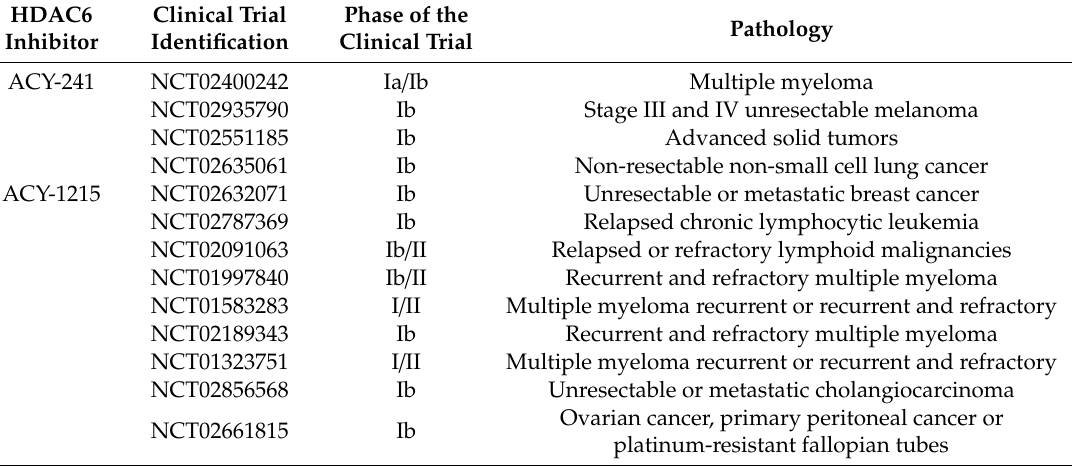
Table 9. HDAC6 Inhibitors in Clinical Trials in Cancer. Clinical studies include four phases. Phase I is performed on healthy volunteers to determine the maximum tolerated dose in humans. Phase II is performed on a limited patient population to determine the optimal dosage. Phase III is performed on several thousand patients and will demonstrate the therapeutic value of the drug and assess its benefit / risk. Phase IV is performed once the drug is marketed and allows to better characterize its adverse e ff